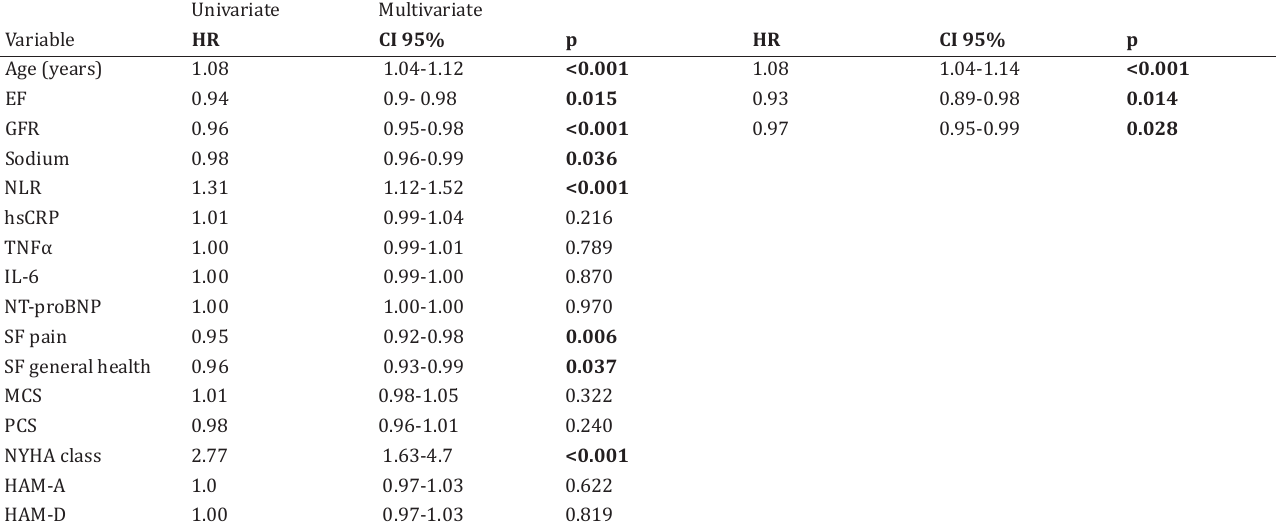
Cox regression analysis for cardiovascular mortality